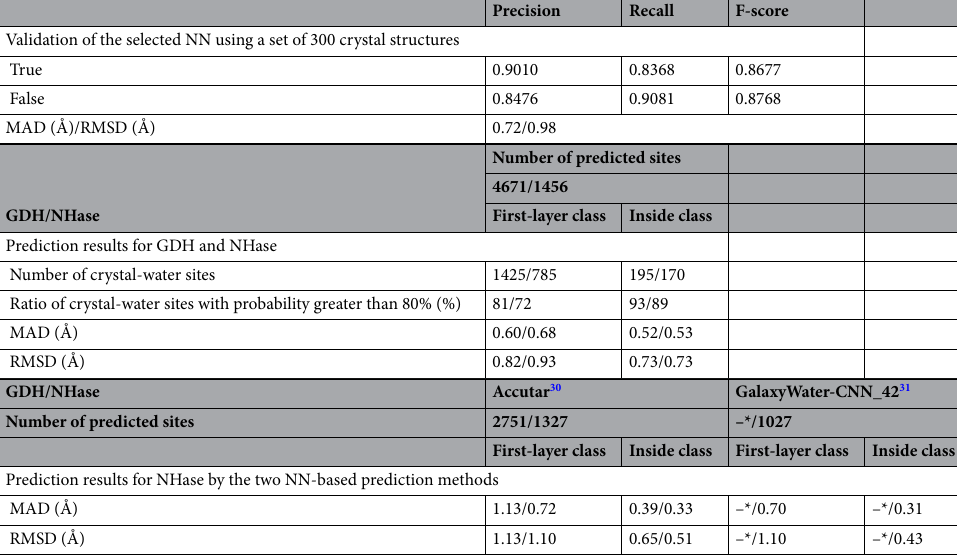
Table 1. Validation and performance of the selected NN. *Because of the limitation on the number of residues in the calculation, the hydration prediction for GDH was not